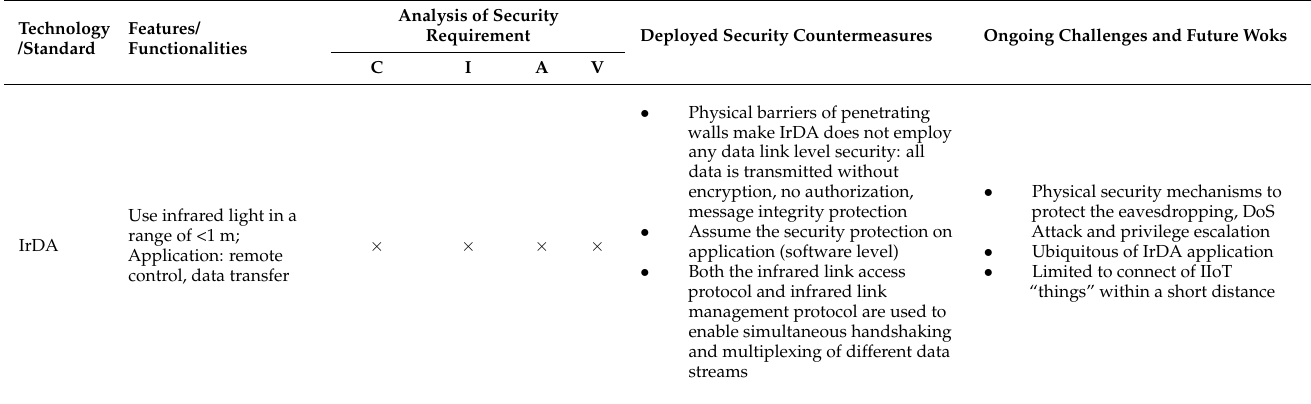
Table 7. Security analysis on capillary network communication